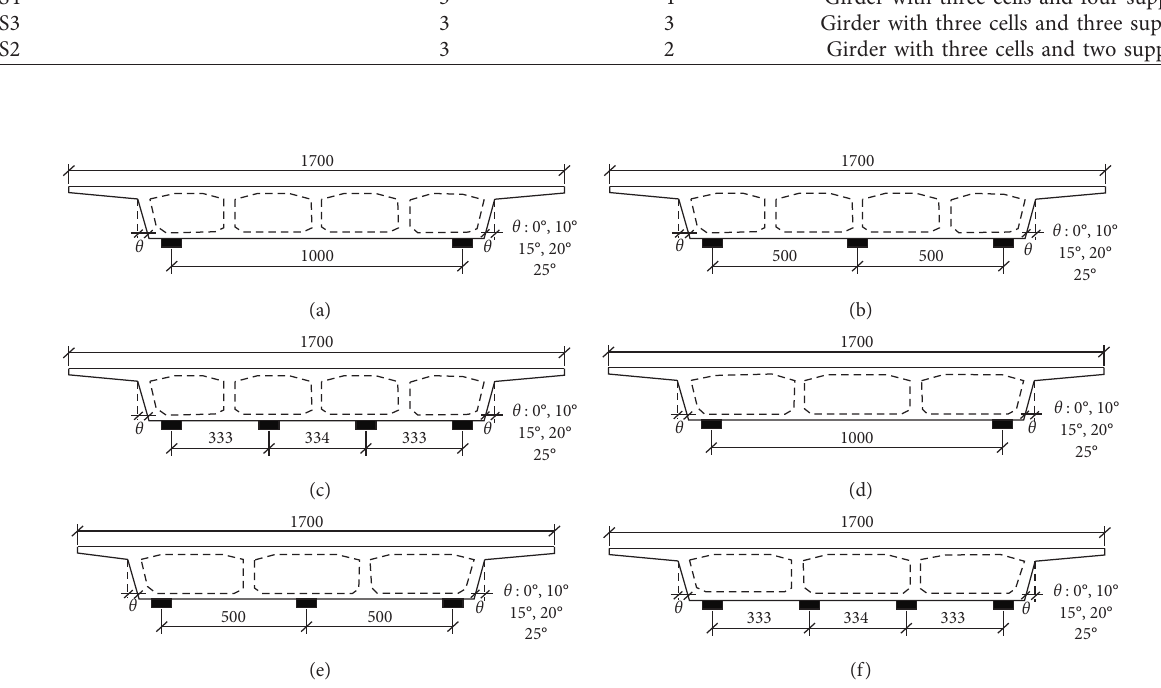
Figure 2: Shear force distribution models. (a) CAS2. (b) C4S3. (c) C4S4. (d) C3S2. (e) C3S3. (f) C3S4.